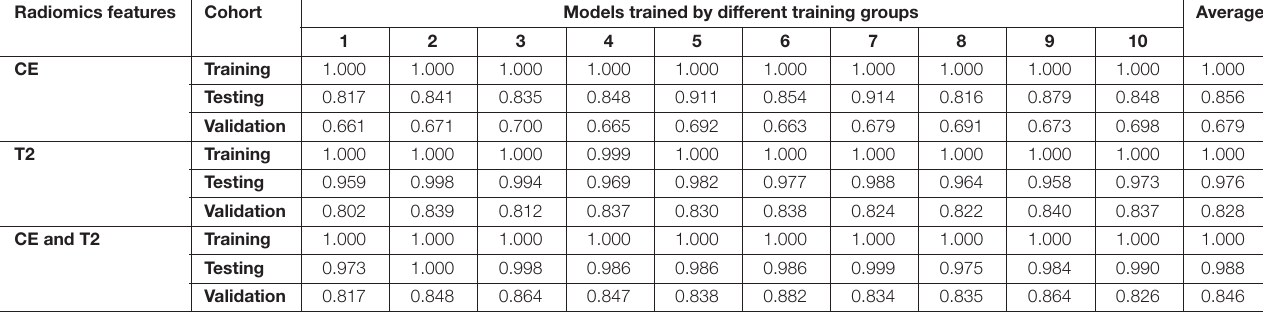
TABLE 2 | Areas under the receiver operating characteristic curves for the 30 predictive models during training, testing, and validation. Radiomics